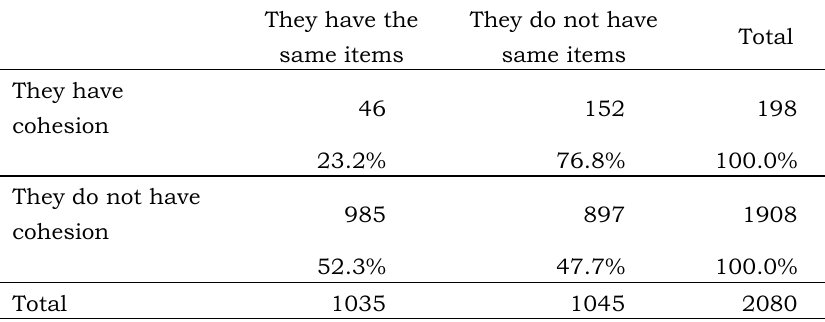
They have the same items